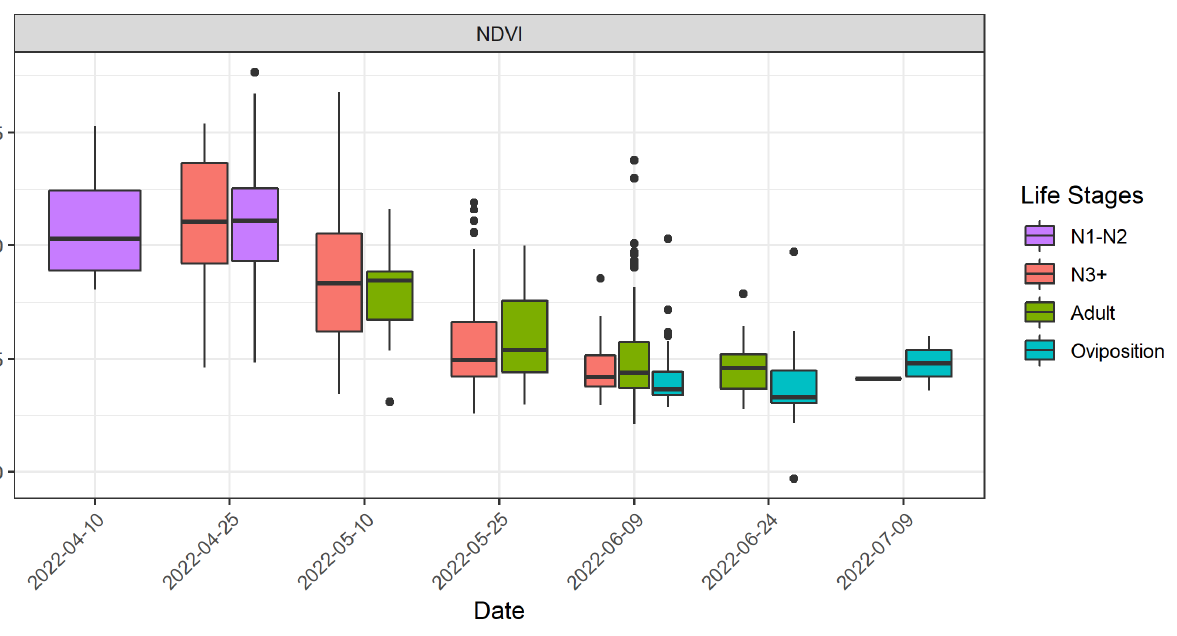
Figure 7. Biweekly NDVI development for different stages of detected DMA locations between April and July 2022.